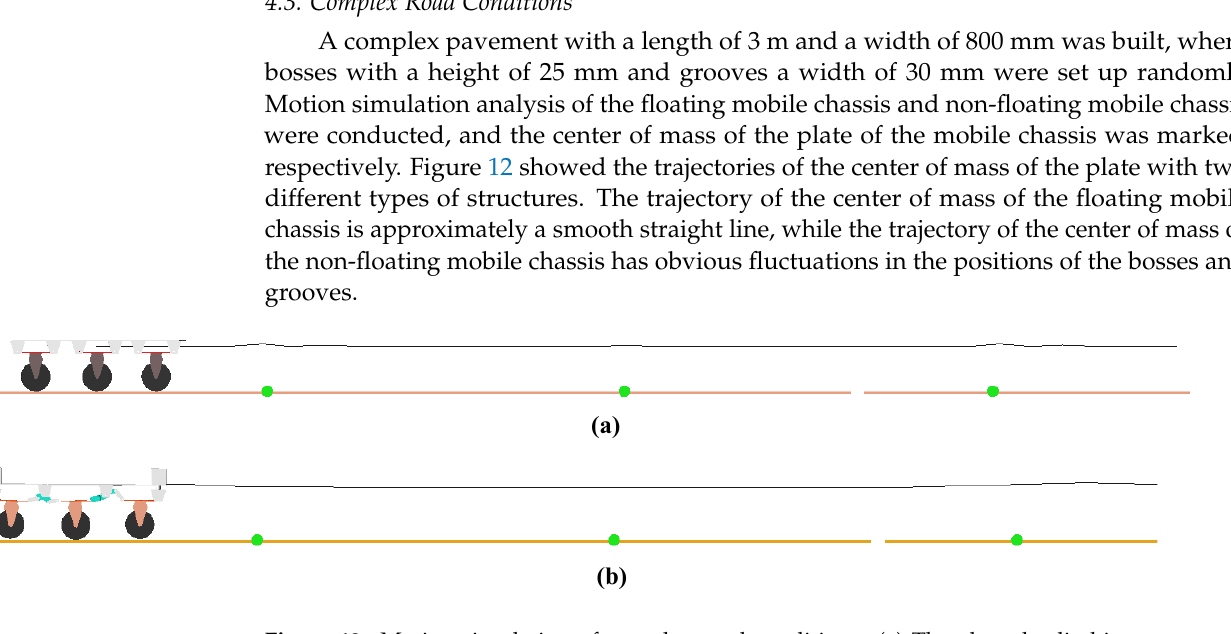
Figure 12. Motion simulation of complex road conditions: ( a ) The obstacle climbing process of floating mobile chassis; ( b ) Dynamic simulation of floating mobile chassis under complex road